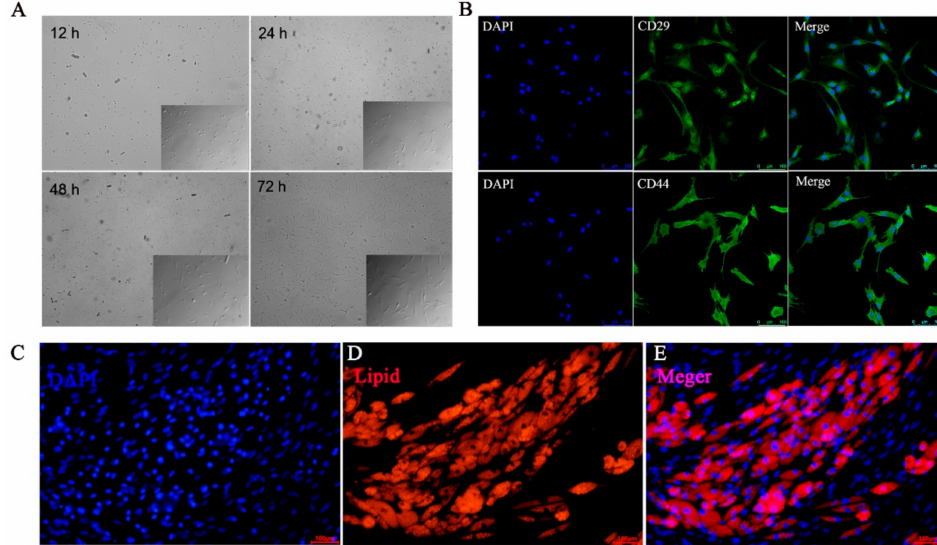
Figure 3. Isolation and identification of porcine ADSCs. ( A ) Cell morphology of ADSCs after isolation for 12–72 h. ( B ) Immunofluorescence staining of ADSCs surface-marker proteins CD29 and CD44. ( C ) 4 (cid:48) ,6-diamidino-2-phenylindole ( DAPI) staining of ADSCs induced by ADM. ( D ) Nile red staining for lipids. ( E ) The merged images of DAPI and Nile